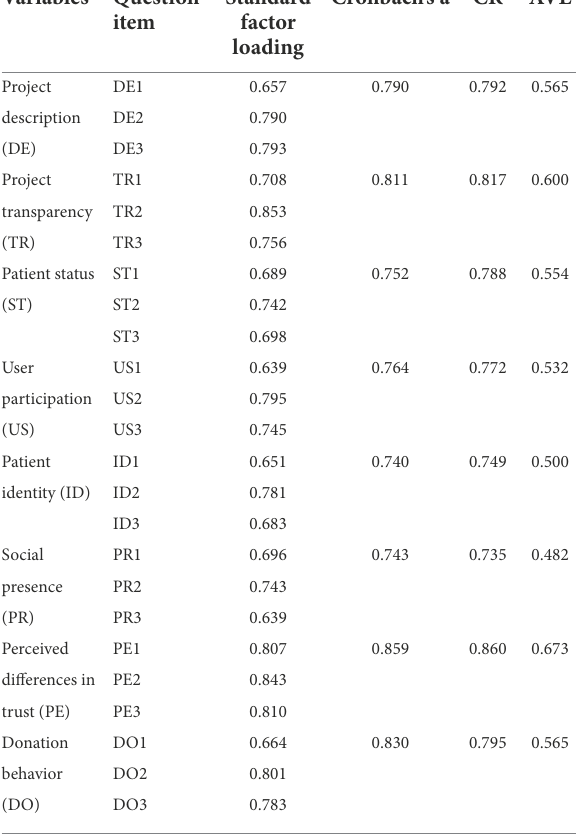
TABLE 2 Reliability and validity test results.